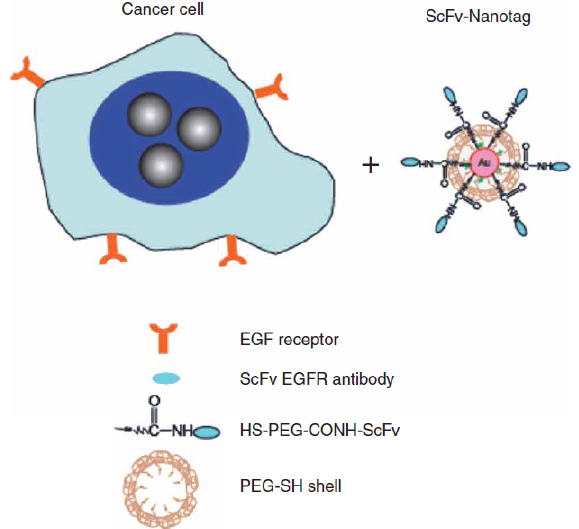
Figure 10. Cancer cell targeting and spectroscopic detection by using antibody-conjugated SERS nanoparticles. Preparation of targeted SERS nanoparticles by using a mixture of SH-PEG (thinly—polyethylene glycol) and a hetero-functional PEG (SH-PEG-COOH). Covalent conjugation of an EGFR-antibody (epidermal growth factor receptor) fragment occurs at the exposed terminal of the hetero-functional PEG. © 2010 Nature Publishing Group.